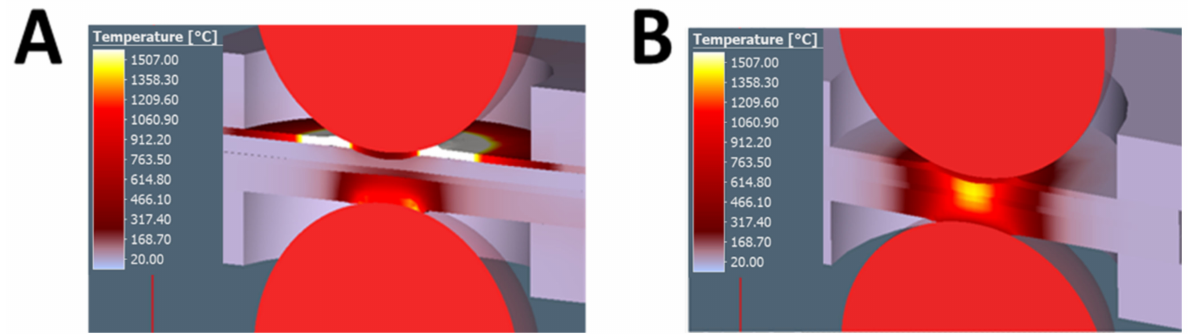
Figure 5. The results of the shunt current-assisted RSW FEM simulation: ( A ) preheating process and ( B ) welding process